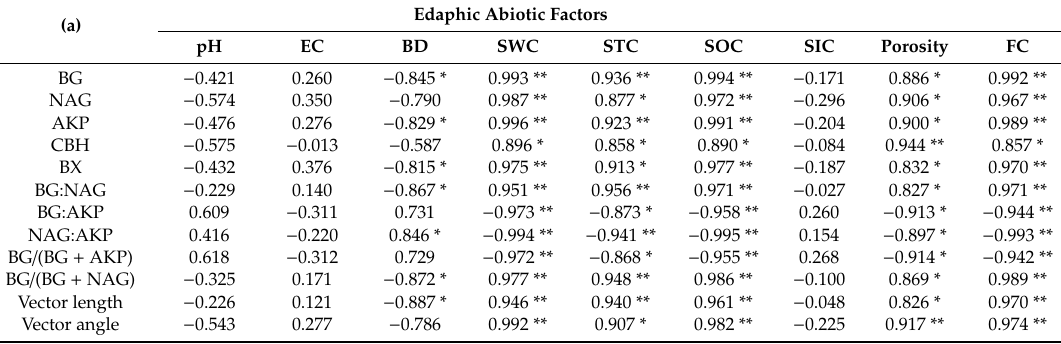
Table 4. Pearson’s correlation coefficients (r) relating soil extracellular enzymes activities, ecoenzymatic stoichiometry and vector characteristics of enzyme activity with ( a ) edaphic abiotic factors (pH, EC, BD, SWC, STC, SOC, SIC, FC) and ( b ) biotic factors (MBC, MBN, MBP, MBC: MBN, MBC: MBP, and MBN: MBP) ( n = 3).